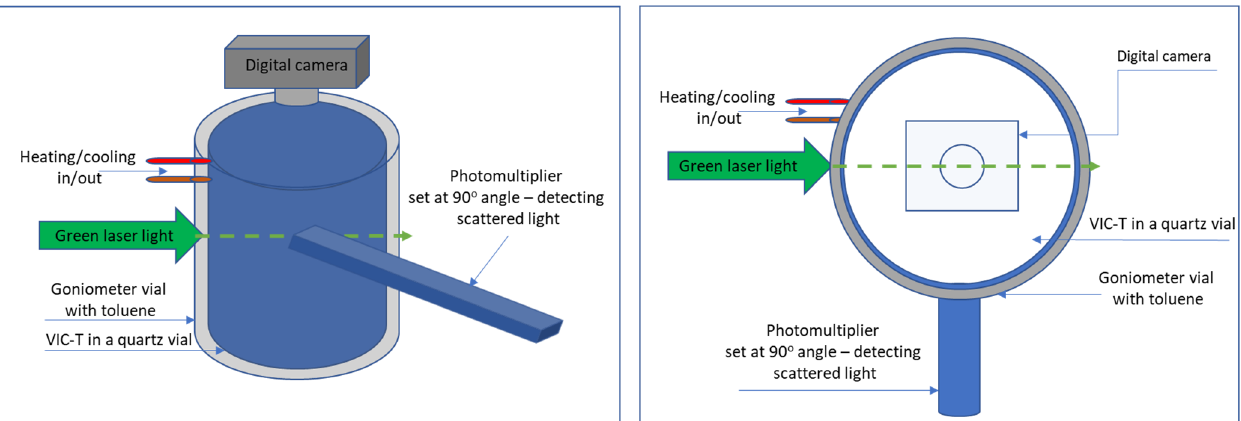
Figure 1. A scheme illustrating the experiment set up; left—side view, right—top view of the SLS-Systemtechnik goniometer with VIC-T dosimeter vial inside the goniometer’s vessel with toluene; a photomultiplier set at 90° angle with respect to a green (532 nm, 5 mW) laser light passing through VIC-T; a digital camera set at the top of the instrument’s goniometer above a niche inside which VIC-T is placed.